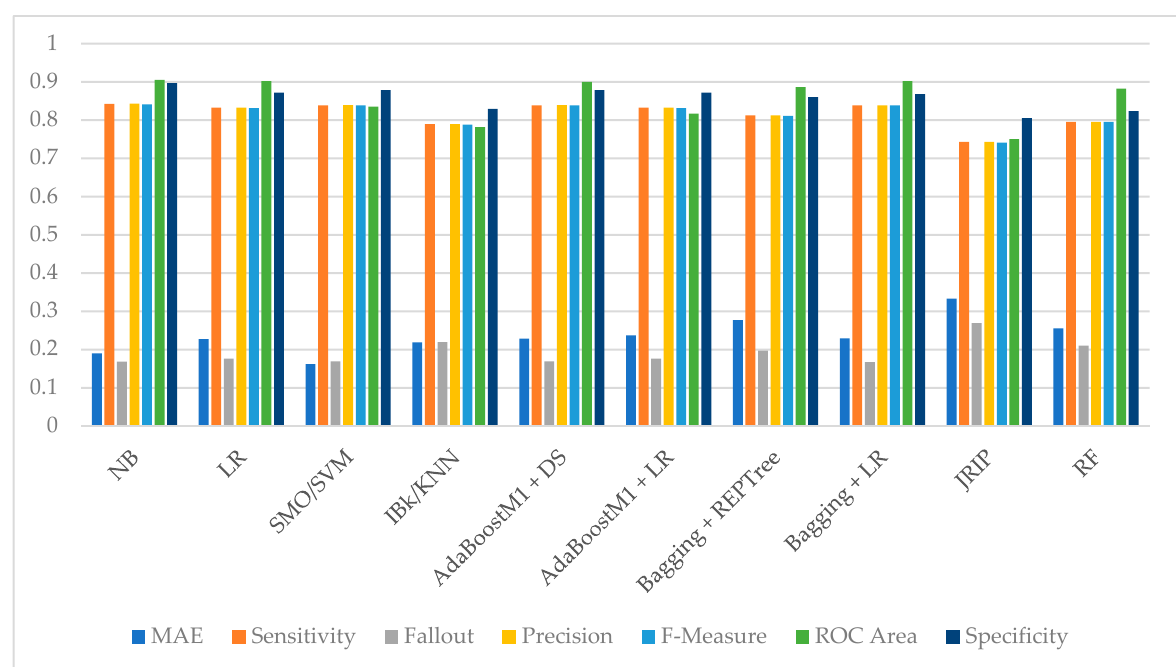
Figure 5. Performance metrics using the optimal set obtained from the correlation-based feature selection technique.